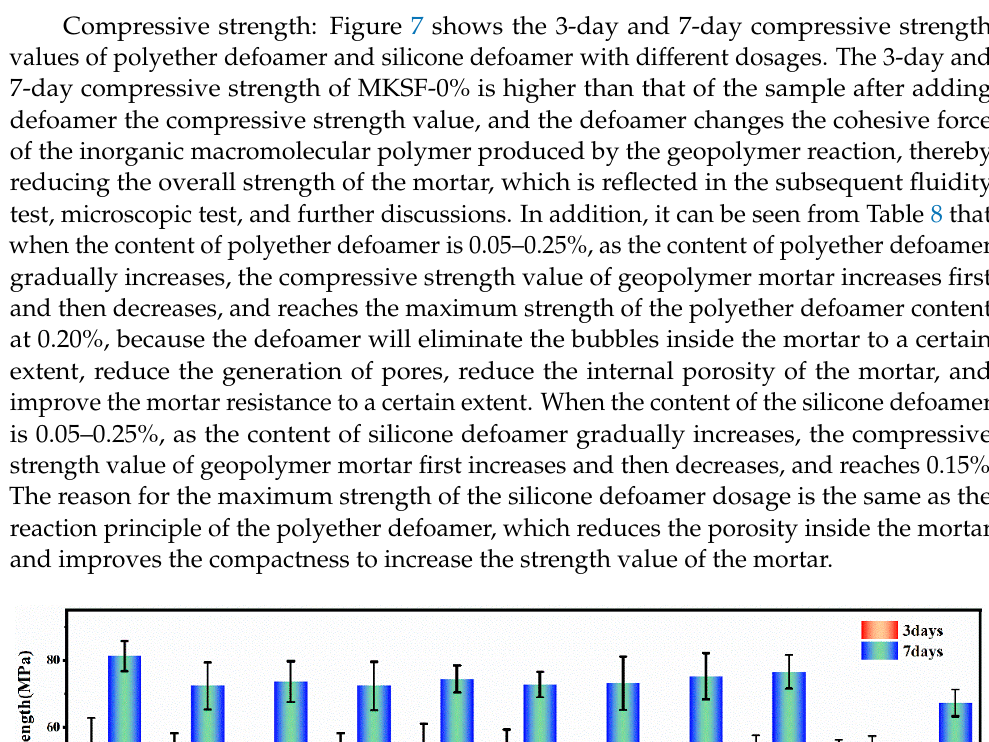
Table 8. The compressive strength of the benchmark group and different amounts of defoamer.